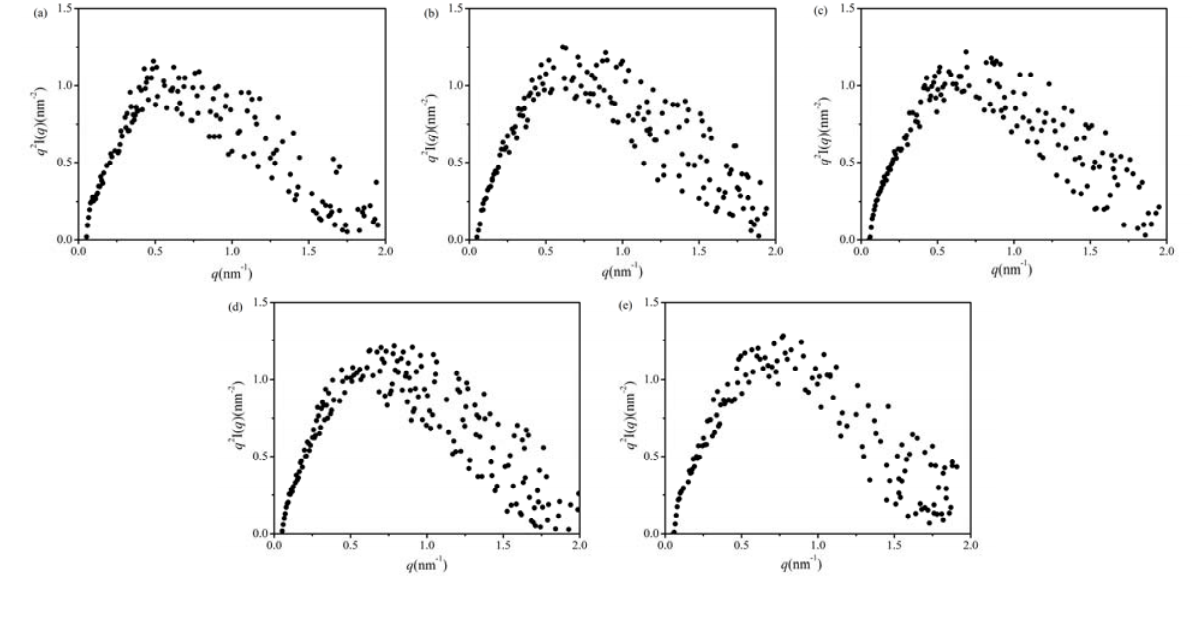
Figure 2. Kratky plots scattering curves from various frozen storage time states of gluten. ( a ) the control gluten. ( b ) 30-days-stored gluten. ( c ) 60-days-stored gluten. ( d ) 90-days-stored gluten. ( e ) 120-days-stored